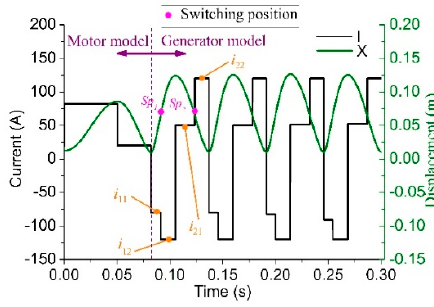
Figure 28. The principle diagram of the ladder-like electromagnetic force control strategy.